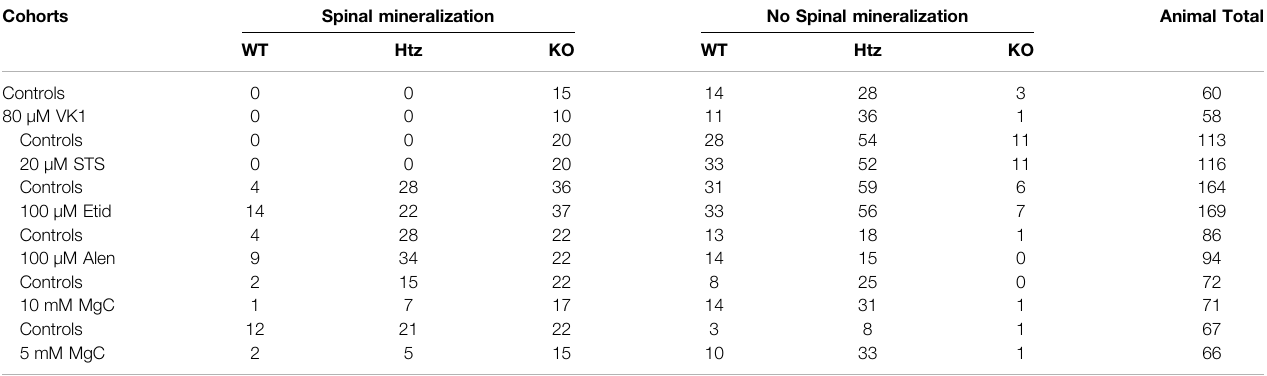
TABLE 1| Geno-andphenotypicdistributionofthelarvae analyzed at10 dpf.Quantities anddistributionoflarvae pergenotypeand phenotype (i.e. presence ofmineralized notochord sections other than the tip) are shown for each compound. WT = abcc6a +/+ wild types, Htz = abcc6a cmg52/+ heterozygotes, KO = abcc6a cmg52/cmg52